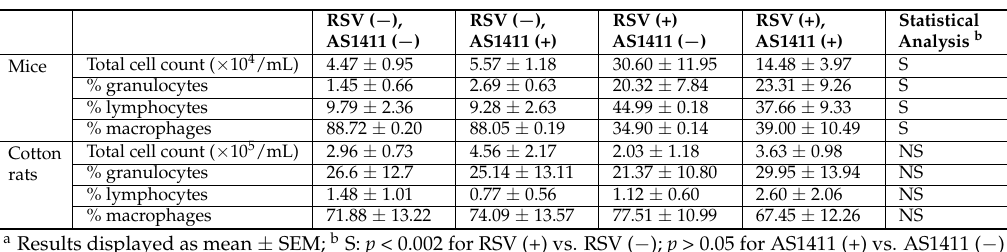
Table 1. BAL cytology for mice and cotton rats a .